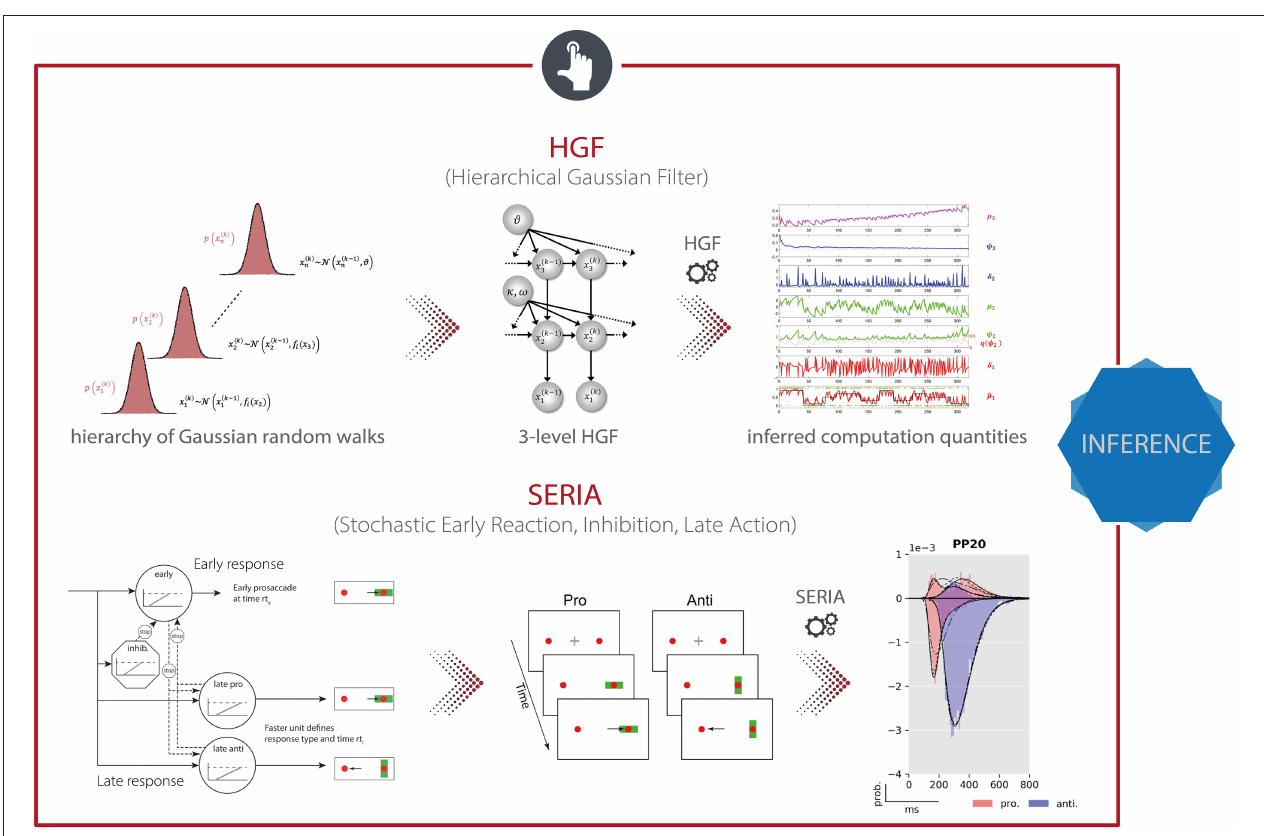
FIGURE 7 | TAPAS components that implement generative models of behavioral data. (Top) The Hierarchical Gaussian Filter (HGF) is a hierarchical Bayesian model for individual learning under different forms of uncertainty (e.g., perceptual uncertainty, environmental volatility). (Bottom) The Stochastic Early Reaction, Inhibition, and late Action (SERIA) model represents a computational model of an agent’s behavior during the antisaccade task by modeling early reflexive and late intentional eye movement via two interacting race-to-threshold